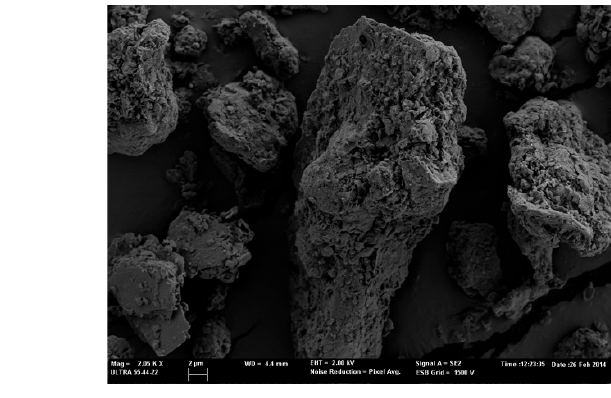
Figure 1. FESEM images of MMT KSF microparticles. ( a ) At 500× magnification and ( b ) at 2000× magnification.